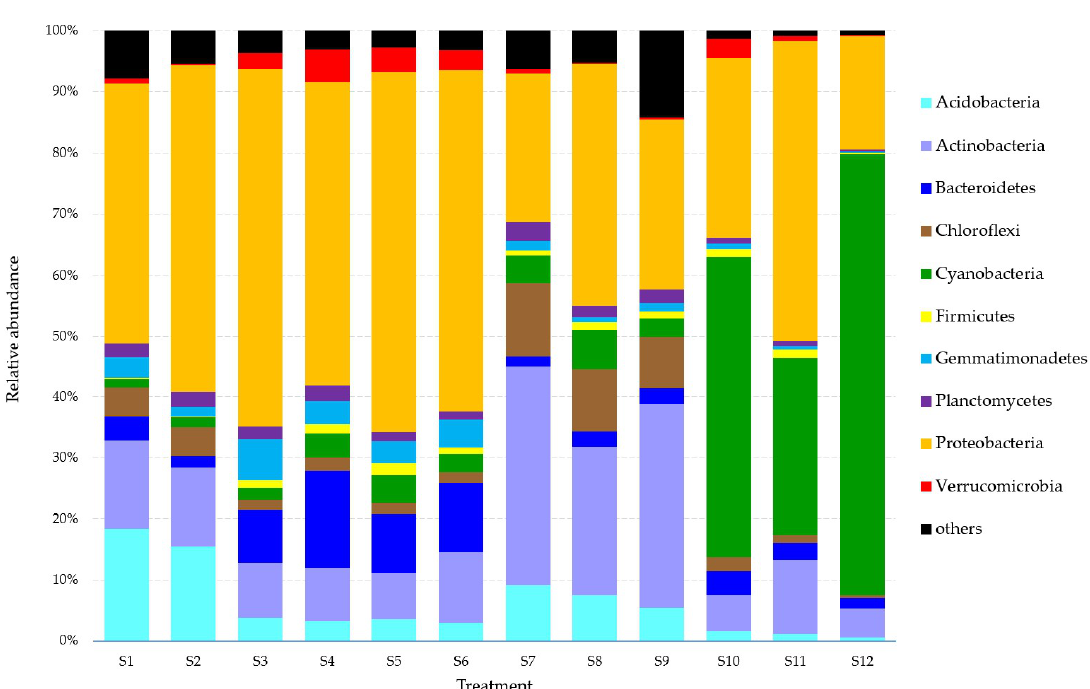
Figure 2. Relative abundance of bacteria at phylum level in different treatments (abundance > 1%). Refer to Figure 1 for treatment details. Each value is the mean of four replicates ± SEM.